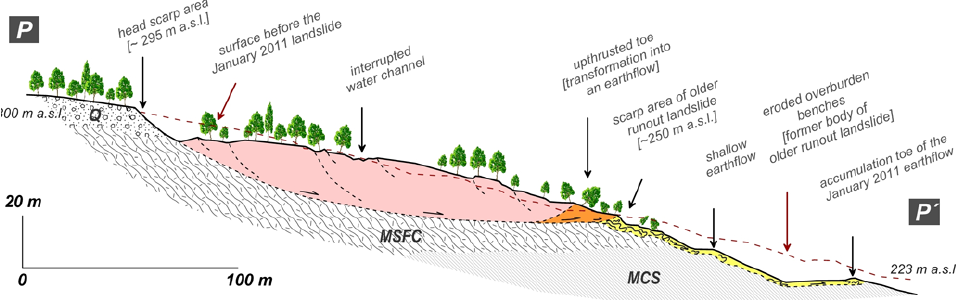
Fig. 6. A generalised longitudinal profile taken across the landslide during January 2011. The profile is based on geomorphological field mapping, ERT interpretation, and the analysis of IB 149, IB 238, and IB 239. Its location is shown in Fig. 2 (Q: Quaternary sediments; MSFC: Miocene stiff-fissured claystones; MCS: Miocene claystones